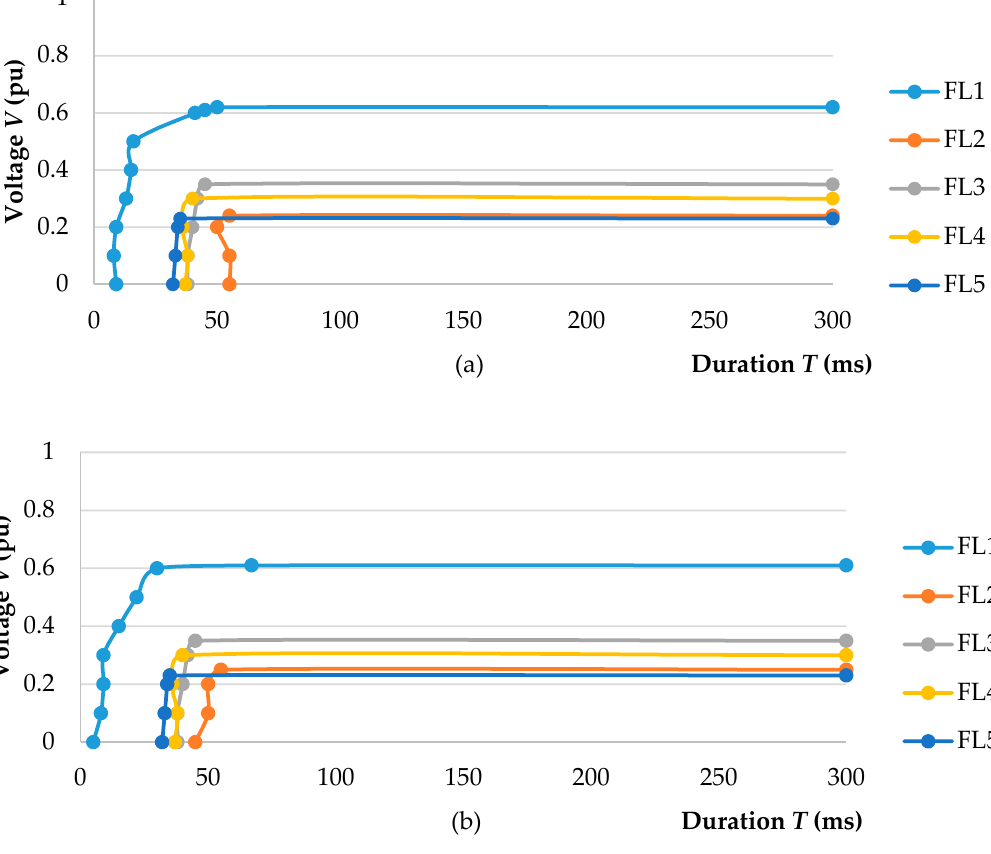
Figure 4. Voltage–tolerance characteristic of fluorescent lamps: ( a ) at phase instant of voltage 0° and ( b ) at phase instant of voltage 90°.